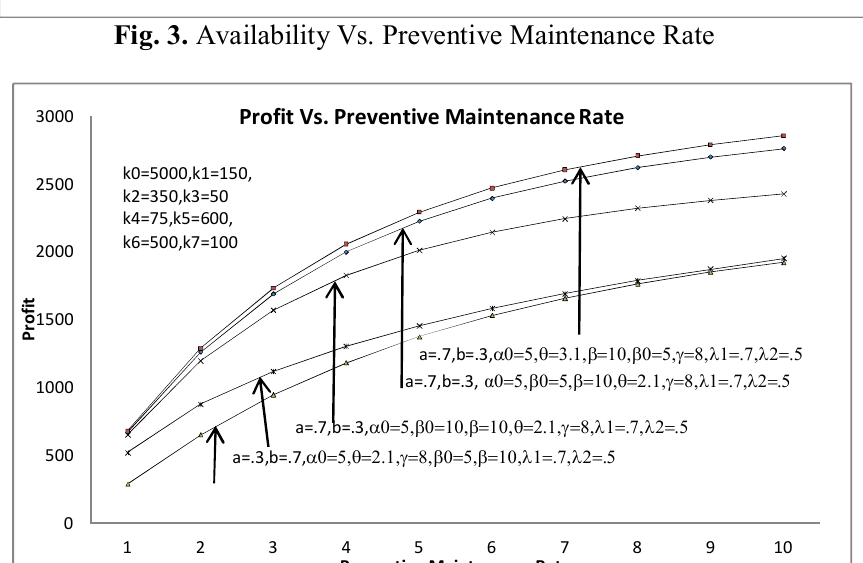
Fig.4. Profit Vs. Preventive Maintenance Rate